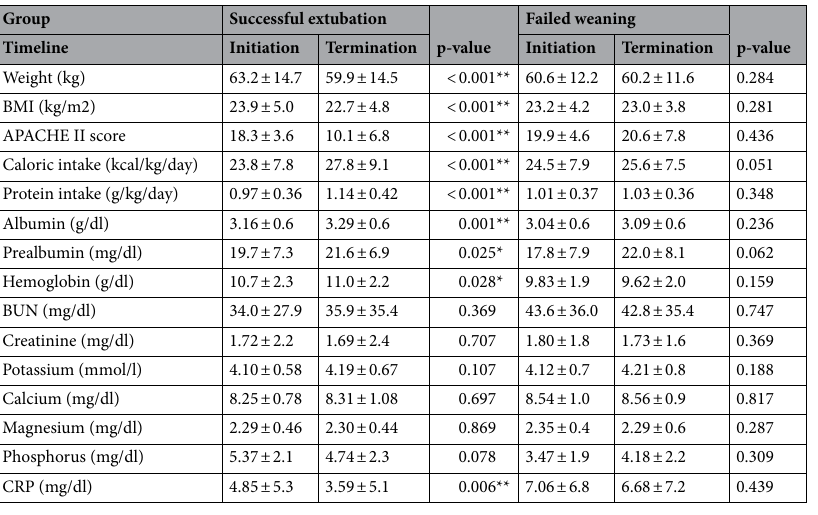
Table 2. Clinical parameters during weaning from mechanical ventilation. Continuous data are expressed as mean ± SD. The p values are from paired t test for continuous variables for within-group comparisons. *The p value < 0.05 and **p value < 0.01 are considered statistically significant and extremely significant, respectively. BMI Body Mass Index, APACHE II score Acute physiology assessment and chronic health evaluation II score, BUN blood urea nitrogen, CRP high sensitivity C reactive protein.